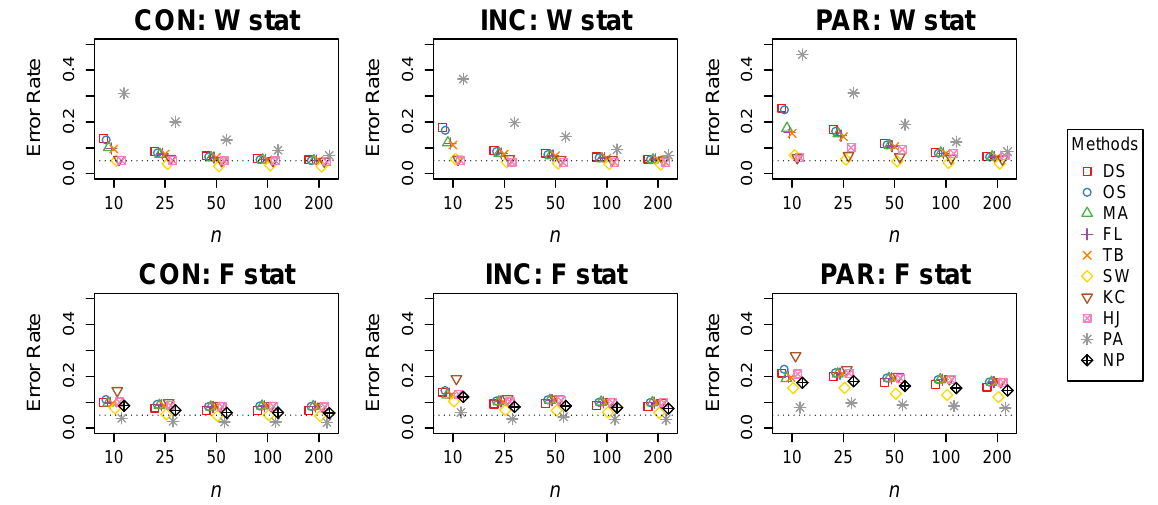
Figure 3. Simulation B results. Within each subplot, the Type I error rate is plotted for each inference method at each sample size. The rows denote the two different test statistics ( W and F ), and the columns denote the three different error standard deviation functions. The nominal α = 0.05 rate is denoted with a dotted